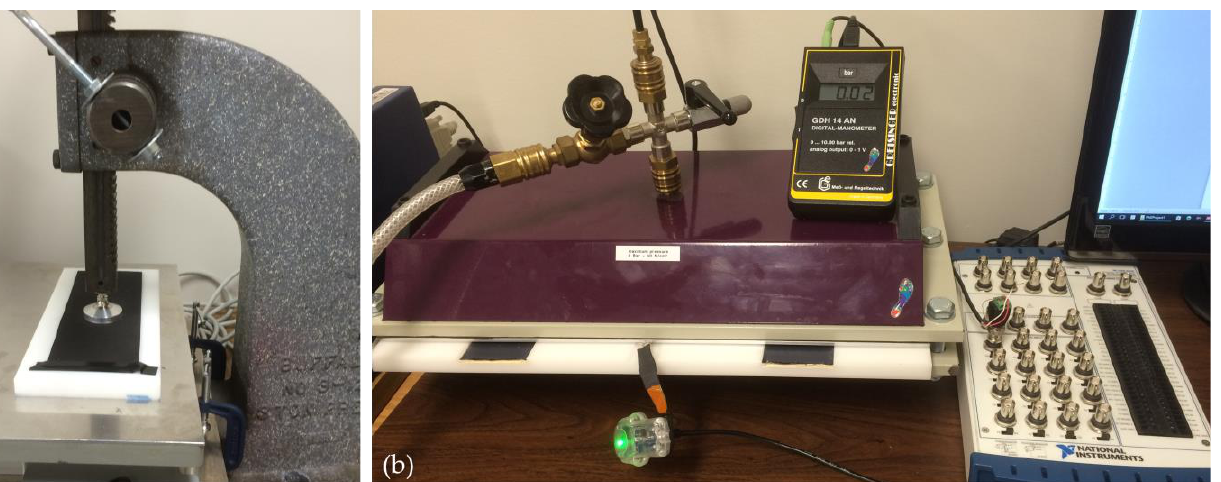
Figure 2. Part 1 testing equipment: ( a ) linear force testing device with 30 mm diameter actuator disk and force plate used for the sinusoidal testing ( b ) pneumatic bladder pressure tester used for step test, static test, and reliability test ( c ) Tekscan F-scan system. Part 2 testing equipment: ( d ) Bertec force-instrumented treadmill. 2. Materials and Methods 2.1. Part 1 — Benchtop Tests 2.1.1. Benchtop Tests Data Collection For the benchtop testing, the SI was tested alongside the sport version of the Tekscan F-Scan insert. Each PPMS was new at the time of testing and used according to the man- ufacturer ’ s specifications. The SI system comes pre-conditioned and calibrated; however, the F-Scan required conditioning, calibration, and equilibration before testing. A two- point calibration at 100 and 500 kPa was performed according to the manufacturer ’s spec- ifications on the sport version of the F-Scan system. The specifications for each of the PPMS are listed in Table 1.